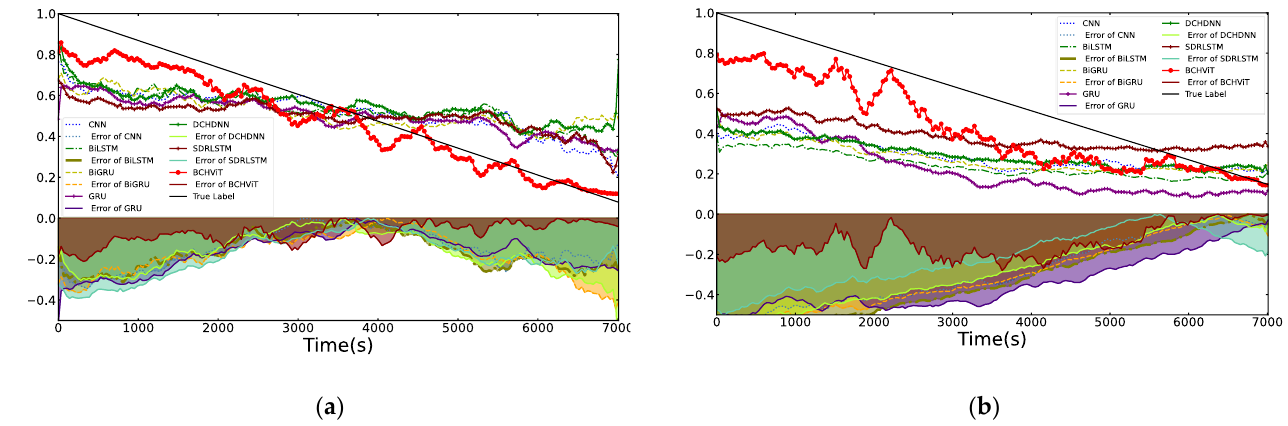
Figure 12. RUL prediction result of different methods: ( a ) Bearing 1-3; ( b ) Bearing 2-6.